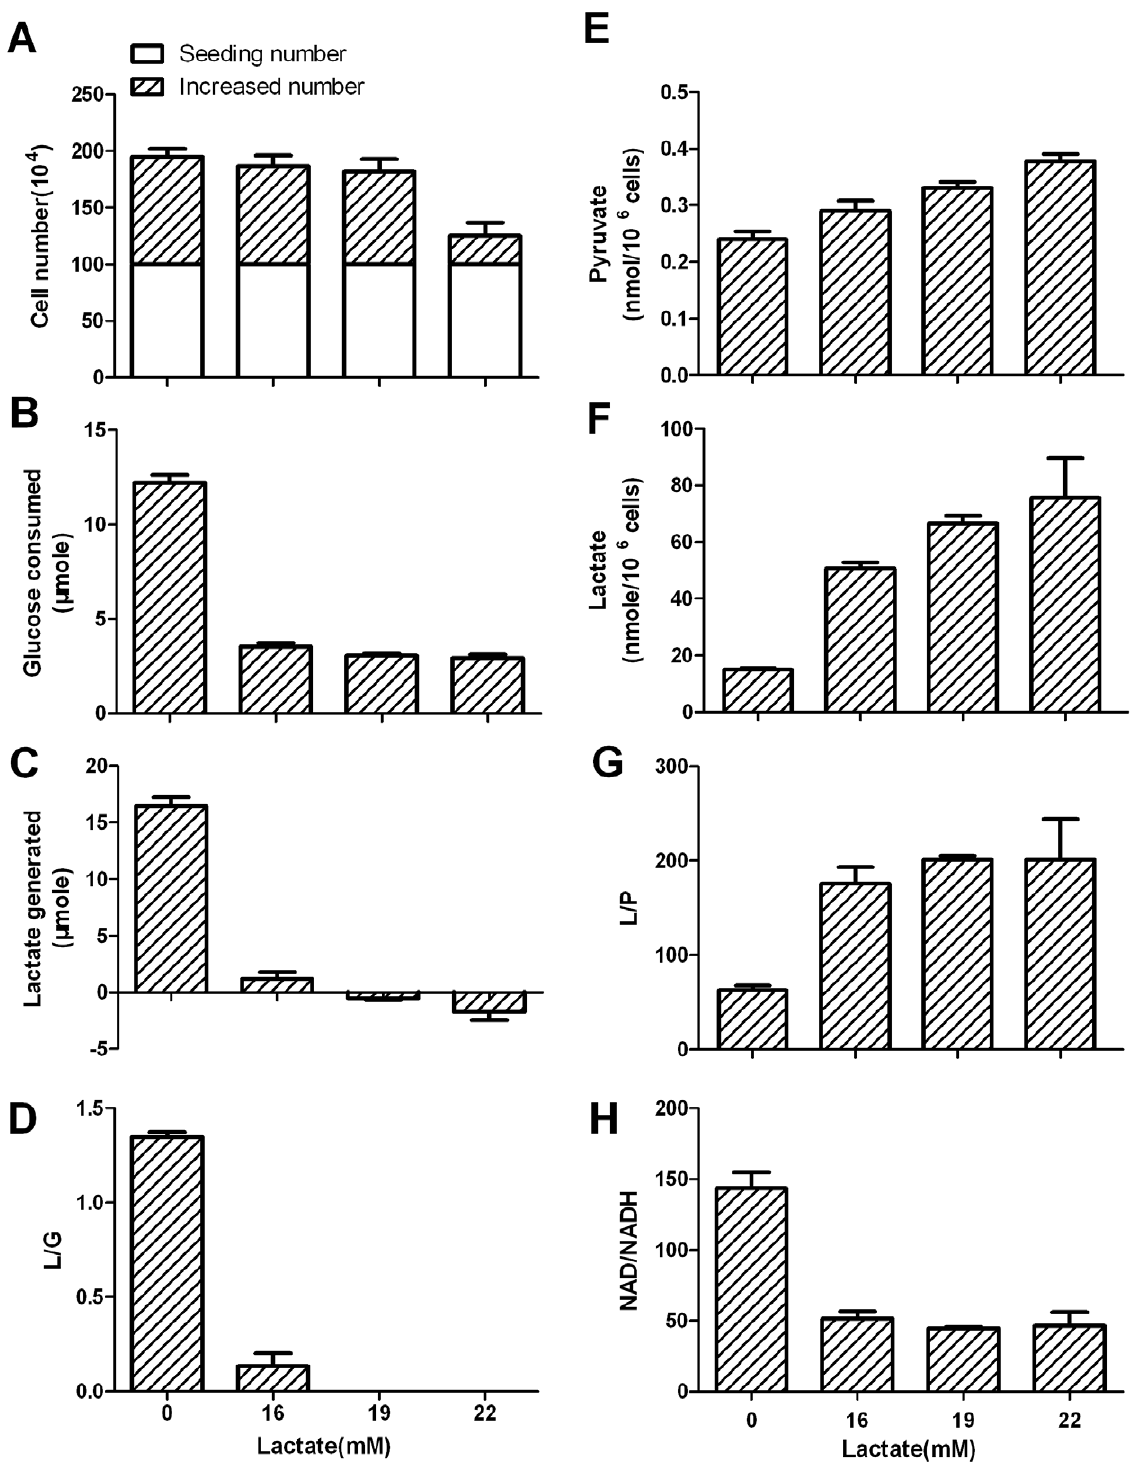
Figure 3. Cytosolic free NAD/NADH ratio estimated at the conversion at equilibrium in Bcap-37 cells. Bcap-37 cells were incubated in complete RPMI-1640 medium containing 12 mM glucose supplemented with or without lactate (x axis). After 24-hour incubation, glucose consumption and lactate generation by Bcap-37 cells, cell growth, and intracellular lactate and pyruvate were measured. (A) Cell proliferation; (B) Glucose consumption; (C) Lactate generation; (D) L/G ratio; (E) Intracellular pyruvate; (F) Intracellular lactate; (G) Intracellular L/P ratio; (H) Cytosolic free NAD/NADH ratio estimated from the corresponding L/P ratio(see corresponding text). Data are mean 6 SD. Data were confirmed by 3 independent experiments.